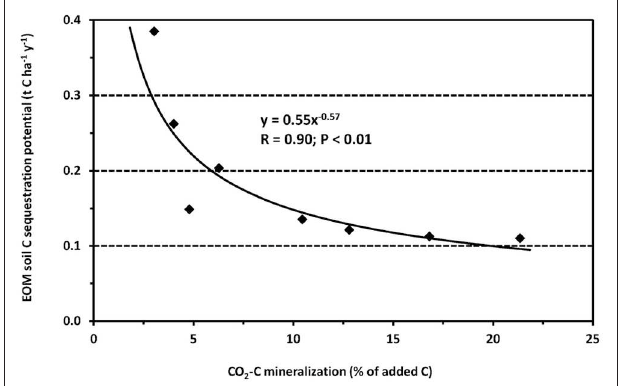
FIGURE 3 | Relationship between net CO 2 -C mineralization and soil C sequestration potential for 8 different EOM